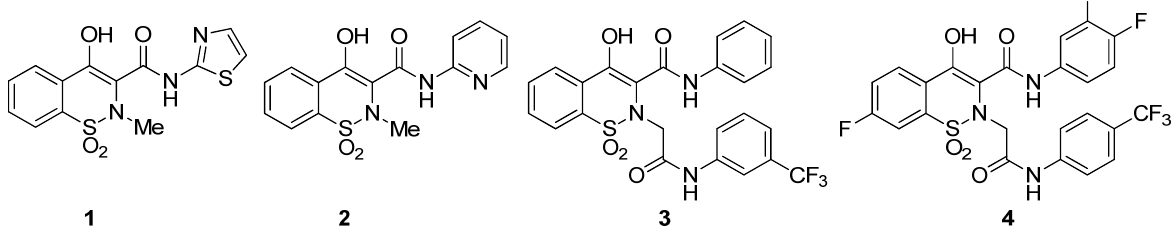
Figure 1. Structures of biologically important 1,2-benzothiazine 1,1-dioxides.